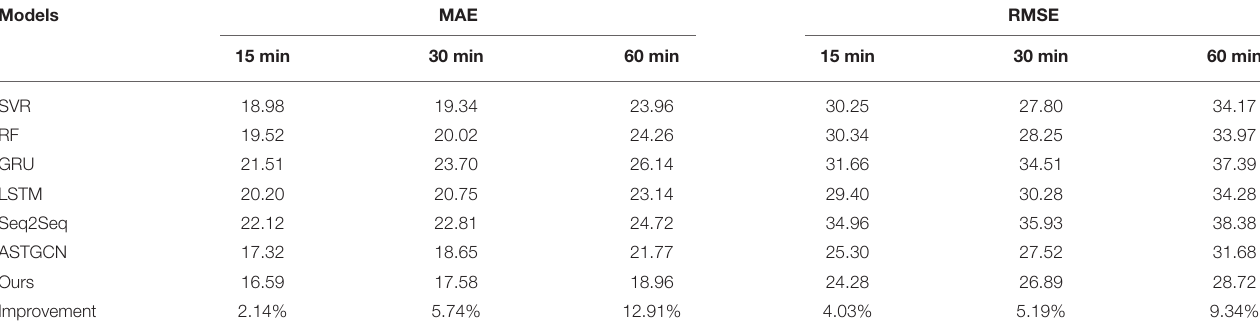
FIGURE 6 | The structure of temporal ensemble attention layer.